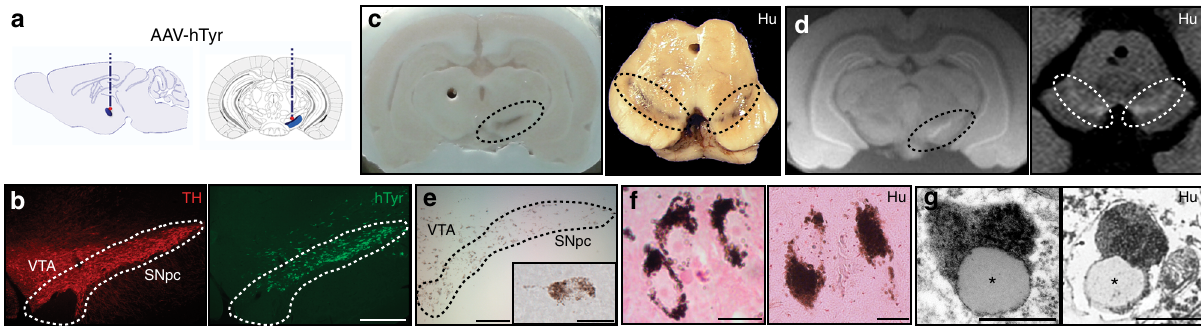
Fig. 1 Human-like NM production in AAV-hTyr-injected rats. a Schematic representation of the site of AAV-hTyr unilateral stereotaxic injection above the SNpc of the rat brain. b Representative photomicrographs of a 30- μ m-thick ipsilateral SNpc section from an AAV-hTyr-injected rat (1 m post-AAV injection) immunostained for TH (red) and hTyr (green). Scale bar, 500 μ m. c Left, representative unstained AAV-hTyr-injected rat brain (2 m post-AAV injection) mounted in a cryostat in which ipsilateral SNpc can be detected macroscopically as a brown, darkened area (dashed outline). A hole was made in the contralateral hemisphere as anatomical reference. Right, representative unstained midbrain from a 62-year-old human control subject (Hu) in which the SNpc can be detected macroscopically (bilateral dashed outlines). d Representative NM-sensitive high-resolution T1-weighted magnetic resonance imaging of an AAV-hTyr-injected rat brain at 2 m post-AAV injection (left, ex-vivo) and of a 59-year-old human control brain (Hu, right, in vivo). SNpc can be detected as a unilateral (AAV-hTyr-injected rodent) or bilateral (human) hyperintense area (dashed outlines). e Representative photomicrograph of an unstained 30- μ m-thick ipsilateral SNpc section from an AAV-hTyr-injected rat (2 m post-AAV injection) in which NM is shown in brown. Inset, high magni fi cation of a melanized neuron. Scale bars, 100 μ m and 12.5 μ m (inset). f Representative photomicrographs of Masson-Fontana melanin staining (NM in dark brown) in 5- μ m-thick SNpc sections from an AAV-hTyr-injected rat at 2 m post-AAV injection (left) and an 80-year-old human control subject (Hu, right). Scale bars, 25 μ m (left) and 12.5 μ m (right). g Representative electron micrograph of NM granules in the ipsilateral SNpc of an AAV-hTyr-injected rat at 4 m post-AAV injection (left) and a 75-year-old human control subject (Hu, right). NM pigment is detected as an electron dense matrix. Characteristic associated lipid droplets are indicated with asterisks. Scale bars, 500 nm